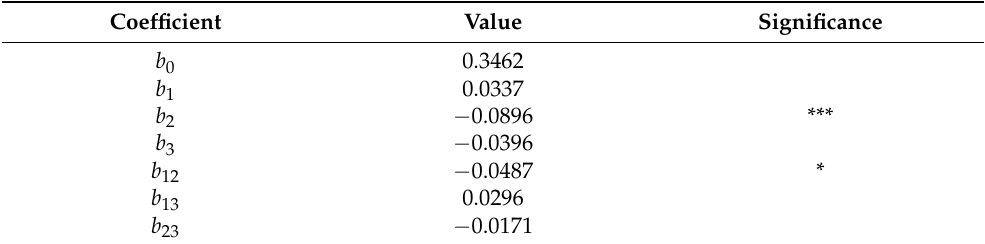
Table 3. Coefficients and significance (* p ≤ 0.05, *** p ≤ 0.001) calculated for the optimization of